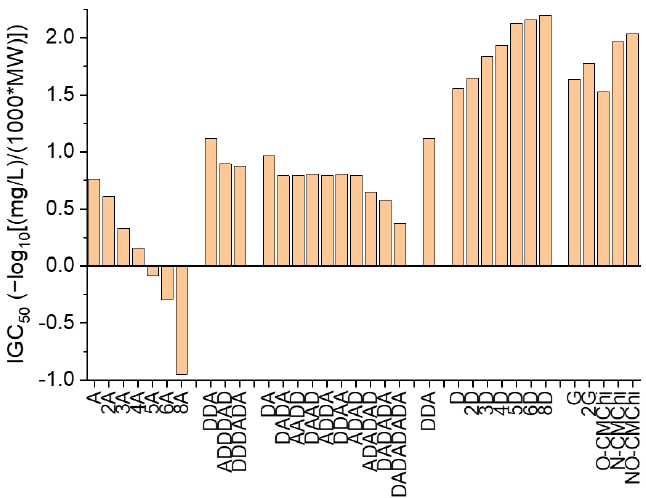
Figure 4. 48 h Tetrahymena pyriformis IGC 50 predicted values for chitooligosaccharides and their derivatives using ADMETLab2.0. The meaning of acronyms on the OX axe are explained in Table in Section 3.2.